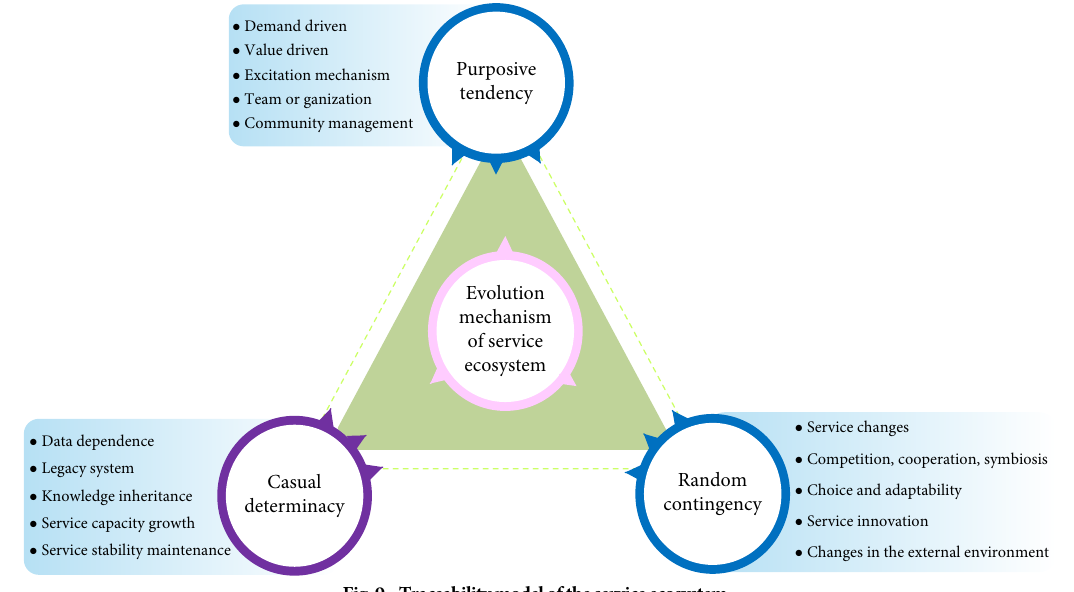
Fig. 9 Traceability model of the service